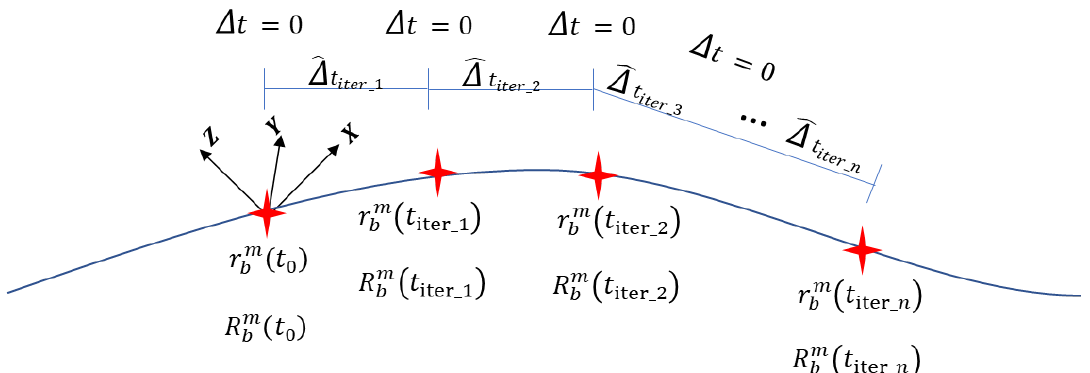
Figure 5. Illustration of the direct approach for time delay estimation within the bundle block adjustment with system self-calibration.